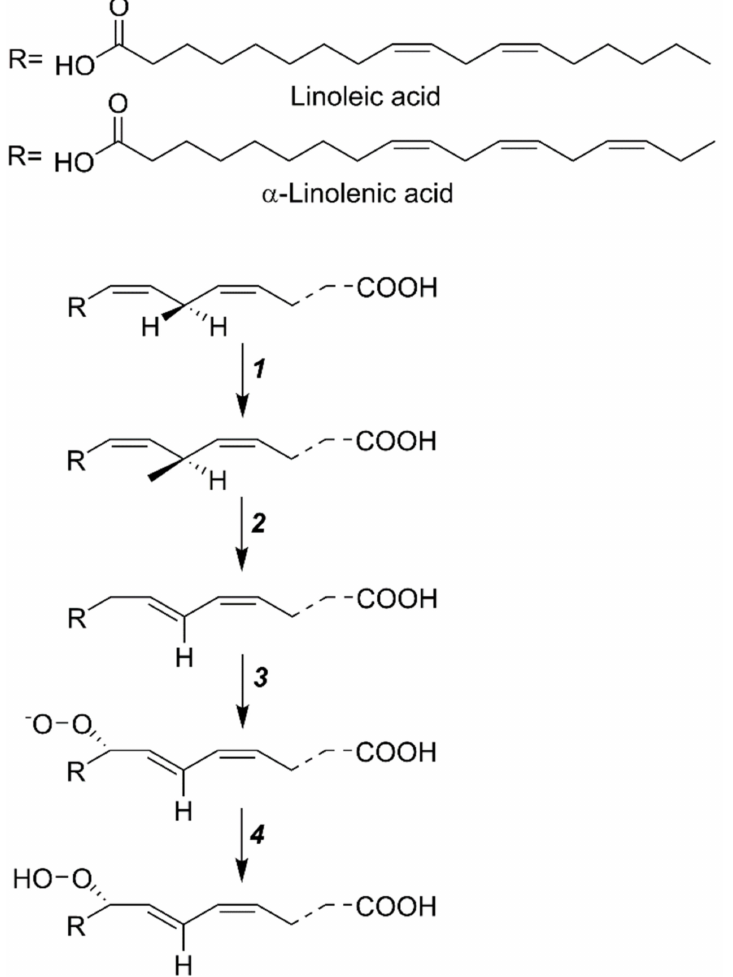
Figure 2. The mechanism of LOX action over the substrate: (1) removal of H + ion from the substrate and the subsequent release of Fe ions, (2) reaction of molecular O 2 with substrate-free radicals to generate peroxide free radicals, (3) transformation of O 2 into oxygen-free radicals, and (4) reduction in peroxide-free radicals by Fe 2+ and H 2 O 2 formation. Finally, it becomes an active LOX enzyme. LOX can catalyze PUFAs and esters with hydroperoxide derivatives, while cis and trans -pentadiene structures, with conjugated double bonds, are synthesized by adding intra-molecular oxygen. In plants, linoleic and linolenic acid act as LOX substrates. Classifi- cation of LOXs is often categorized based on their positional specificity for the oxygenation of unsaturated fatty acids. In linoleic acid, the 9 and 13-carbon atoms in the fatty acid chain are oxygenated by 9-LOX and 13-LOX, respectively [17]. LOX catalyzes deoxygenation of region and stereo-specific (1 Z , 4 Z )-pentadienes into conjugated ( Z , E )-diene hydroperoxy fatty acids (HPO). Degradation of HPO produces metabolites, volatile chemicals, conju- gated dienoic acids, methyl jasmonate (MeJA), and jasmonic acid (JA); these composites are active participants of plant defense-related activities [18], including biotic and abiotic